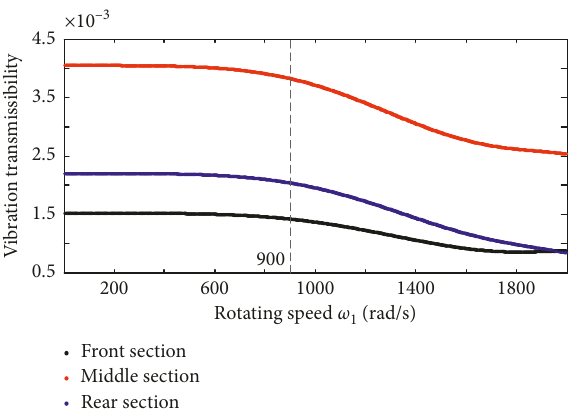
Figure 11: Response relativity R with varying rotating speed of low-pressure rotor ω l : front section (black), middle section (red), and rear section